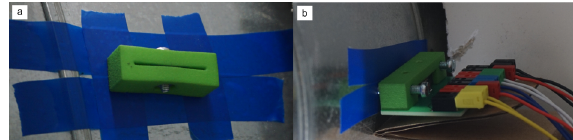
Figure 8. Mounting of the sensor in the flow channel via two slots. ( a ) 3D printed part (green) for tip of the sensor with a screw for tightening. ( b ) Sensor locked on the linkage PCB. The sensor is placed on a female connector and tightened via a 3D printed part